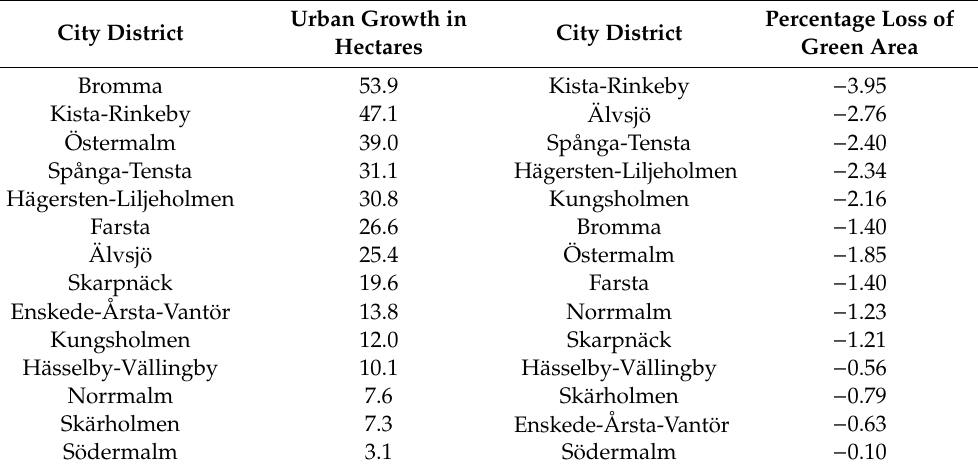
Table 3. Urban and green area changes per district.